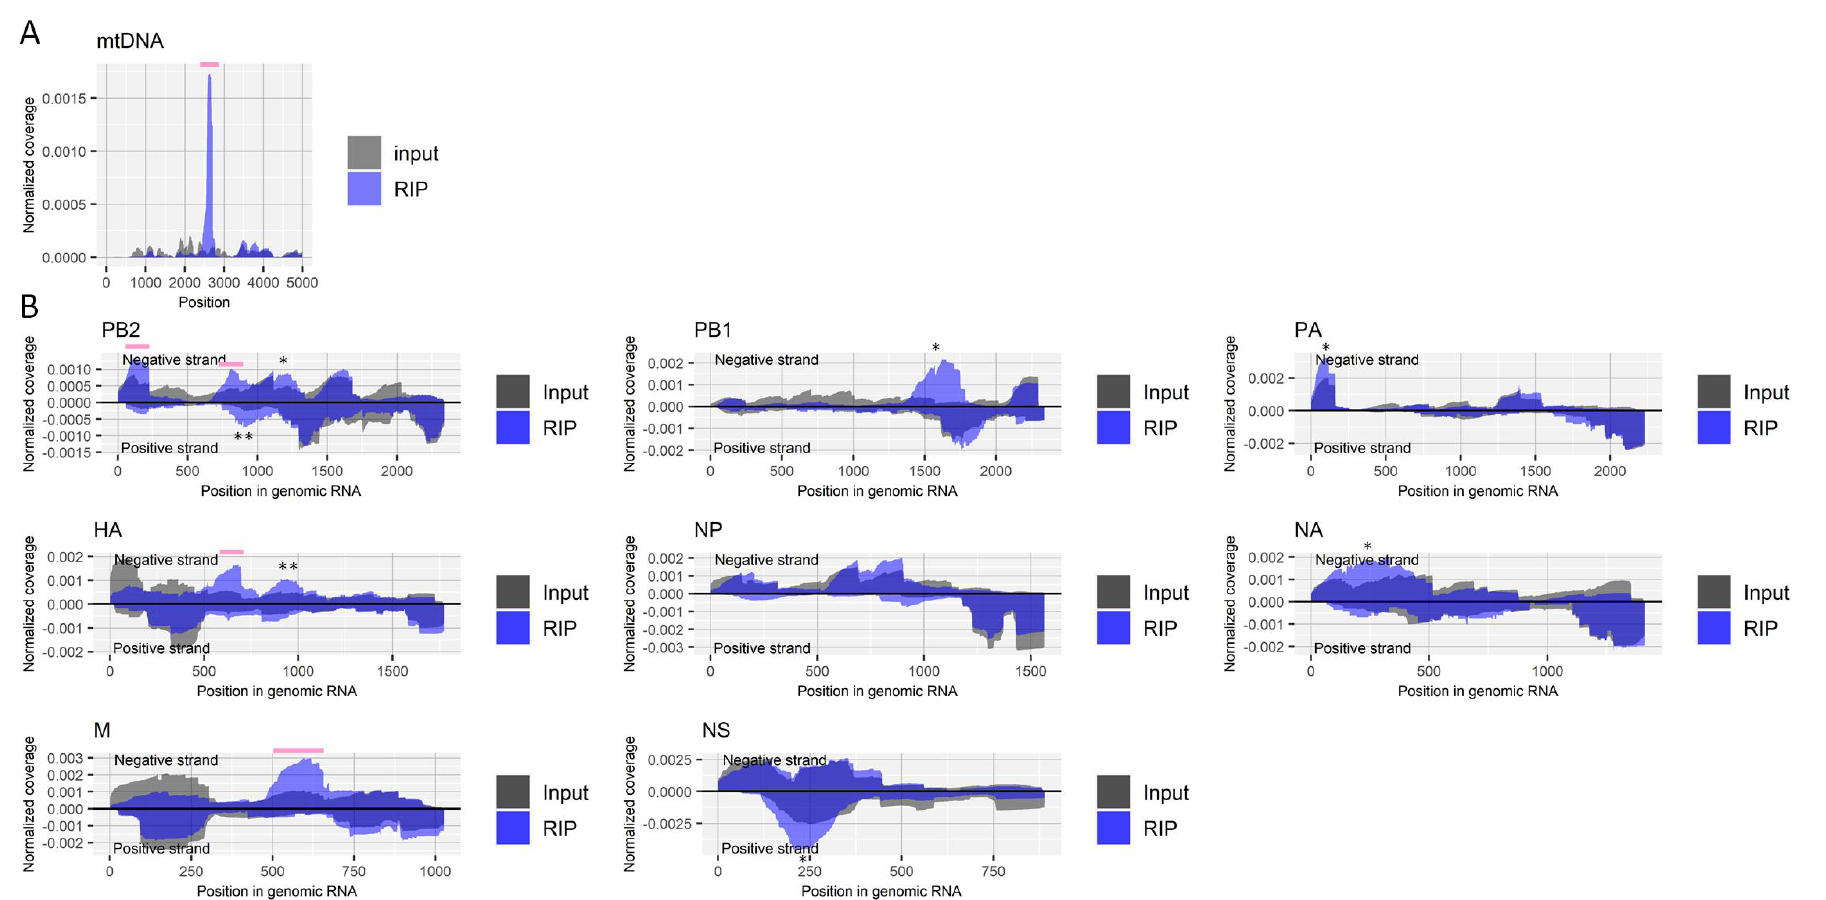
Figure 2. Detection of regions that include m1A in RNA derived from influenza A virus. ( A ) Read coverage of deep-sequencing in the host’s mitochondrial chromosome normalized by the number of read counts mapped to the entire chromosome for RIP and input samples. A pink bar indicates a known region that includes an m1A site. ( B ) Read coverage of deep-sequencing in negative-strand RNA (positive values) and positive-strand RNA (negative values) of each viral segment normalized by the number of read counts mapped to each transcript for RIP and input samples. Pink bars indicate enriched regions that possibly contain m1A. The criteria to identify RIP-enriched regions were at least two-fold enrichment, m1A antibody-specific enrichment, and enrichment in two biological duplicates. * non-specifically enriched region that was also observed in other experiments. ** non-specifically enriched region that was not observed in the biological replicate experiment. Results of the biological replicate experiment are available in Supplementary Figure S2.